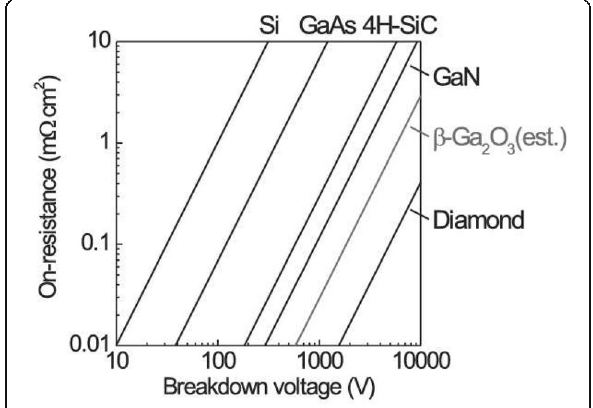
Fig. 3 Theoretical limits of on-resistance ( R on ) as a function of breakdown voltage ( V br ) for β -Ga 2 O 3 and representative semiconductors. Reprinted from ref.